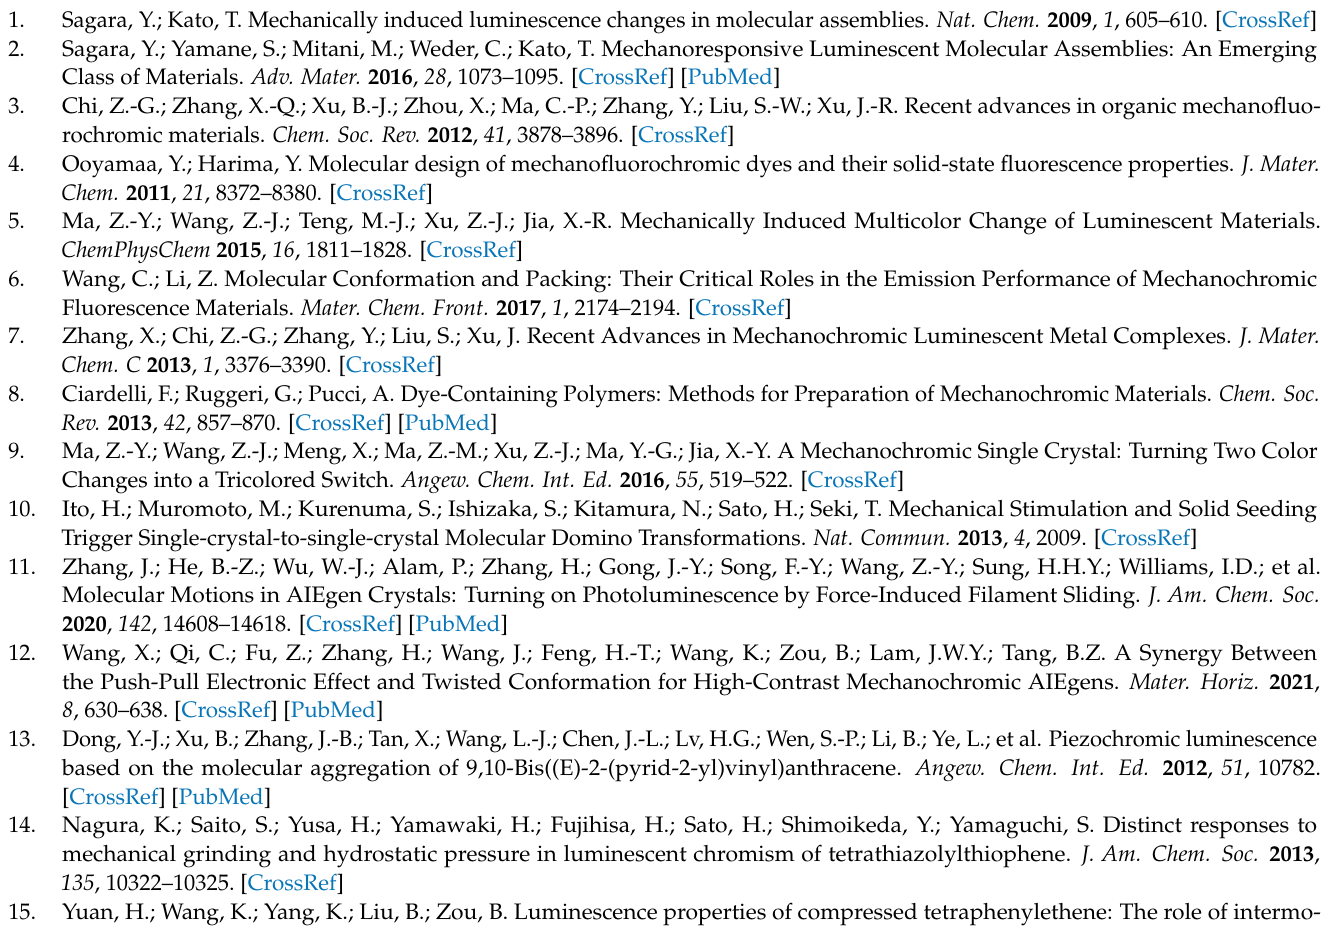
Figure S28: solid-state UV-vis spectra; Figure S29: Transient PL decay curves of solids 1 – 6 before and after anisotropic grinding; Figure S30: Normalized Intensity PL spectra of molecule 1 – 6 under the different excitation wavelength; Figure S31: UV-vis spectra of solids 1 – 6 before and after